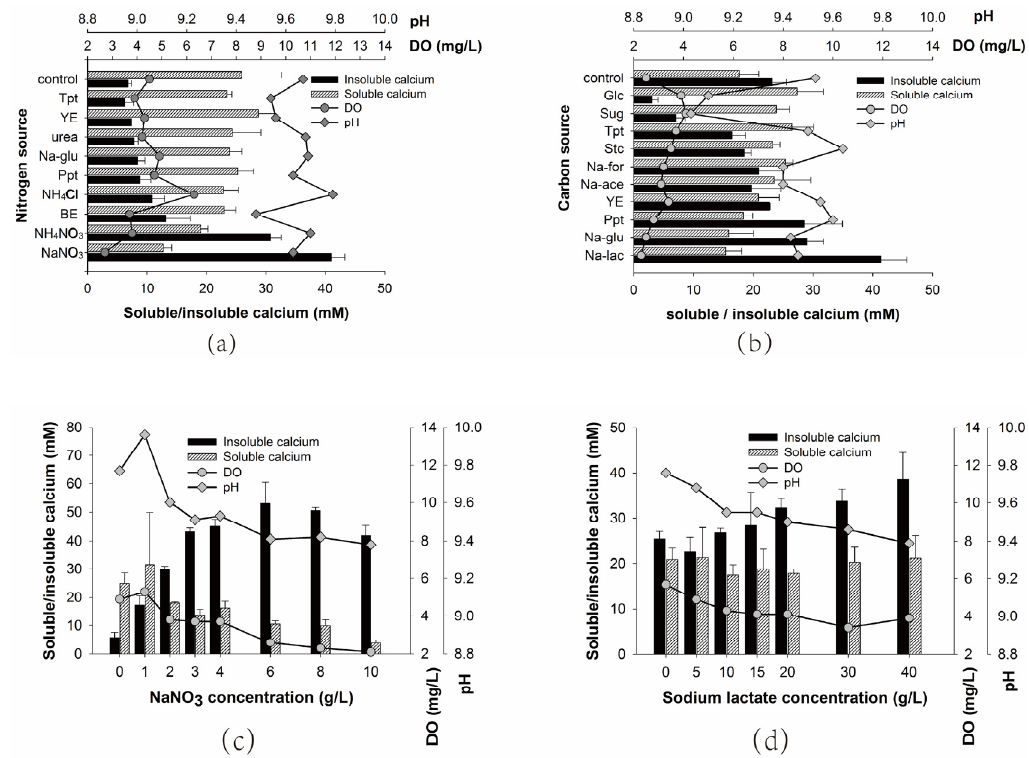
Figure 4. The effect of carbon source, nitrogen source and their concentrations (c ， d) on bacteria Figure 3. The effect of carbon source, nitrogen source and their concentrations ( c , d ) on bacteria induced induced calcium precipitation. ( a ) Na ‐ glu sodium glutamate, YE yeast extract, BE beef extract, Tpt calcium precipitation. ( a ) Na-glu sodium glutamate, YE yeast extract, BE beef extract, Tpt tryptone, tryptone, Ppt microbiological peptone. ( b ) Na ‐ for sodium formate, Sug sugar, Glc glucose, Stc starch, Ppt microbiological peptone; ( b ) Na-for sodium formate, Sug sugar, Glc glucose, Stc starch, Na-ace Na ‐ ace sodium acetate, Na ‐ lac sodium lactate, YE yeast extract, Tpt tryptone, Na ‐ glu sodium sodium acetate, Na-lac sodium lactate, YE yeast extract, Tpt tryptone, Na-glu sodium glutamate, Ppt glutamate, Ppt microbiological peptone. microbiological